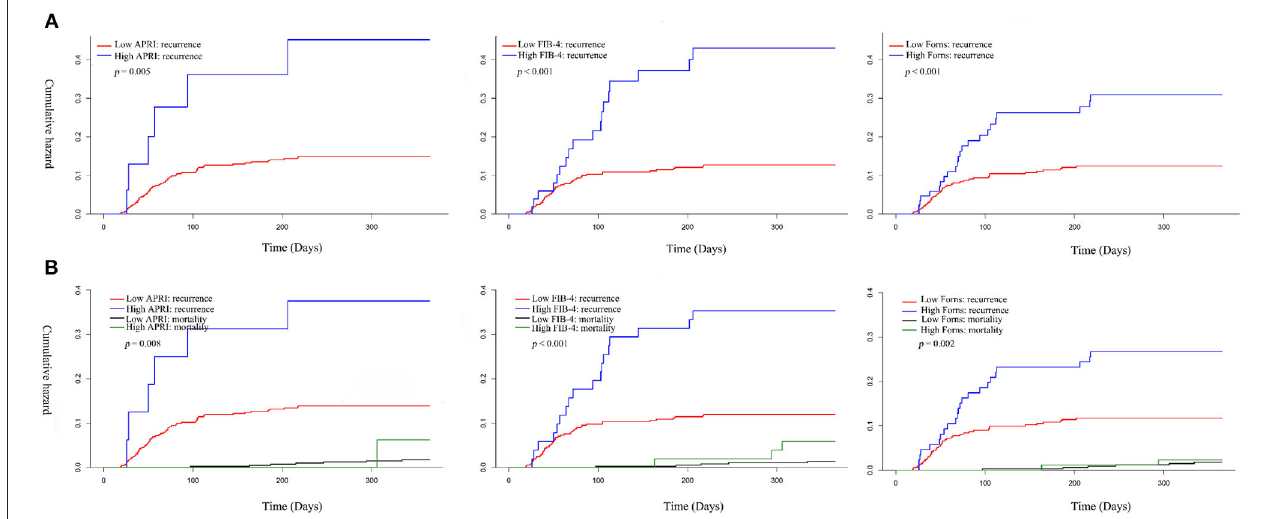
FIGURE 2 | Cumulative hazard of recurrence and competing mortality in patients with CSDH according to low and high Q19 liver fibrosis scores. (A) Kaplan–Meier method; (B) Kaplan–Meier method.